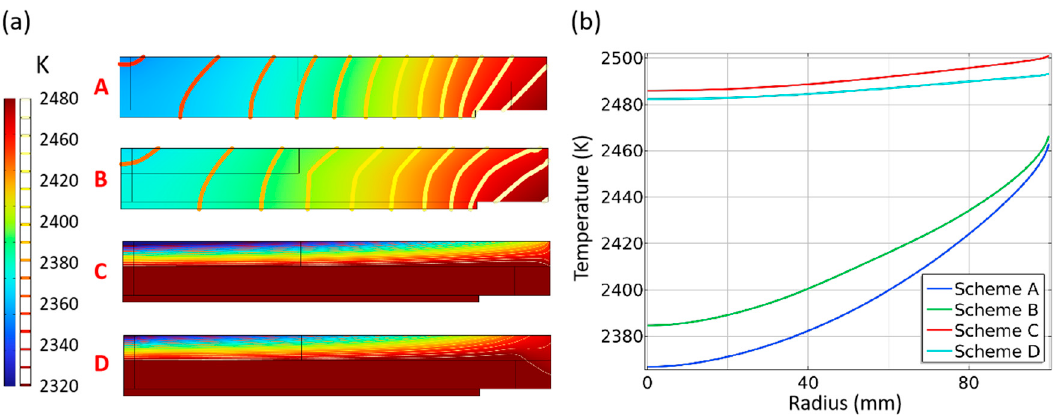
Figure 5. ( a ) Temperature distribution of the seed crystal ( A ) Scheme A; ( B ) Scheme B; ( C ) Scheme C; ( D ) Scheme D; ( b ) seed crystal surface temperature of different schemes.